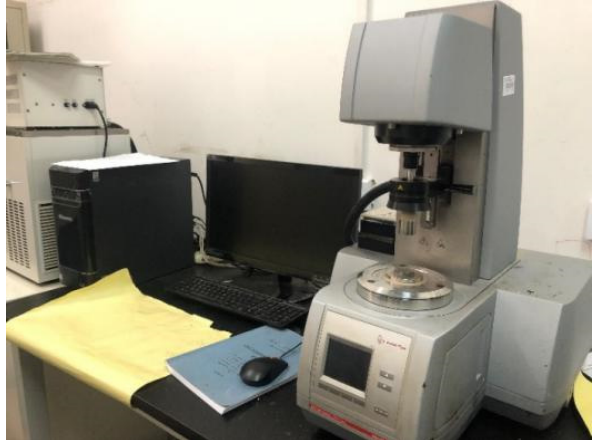
Figure 5. Dynamic shear rheometer (DSR) equipment consists of a temperature control system, a stress and strain control system, and an automatic data analysis system.